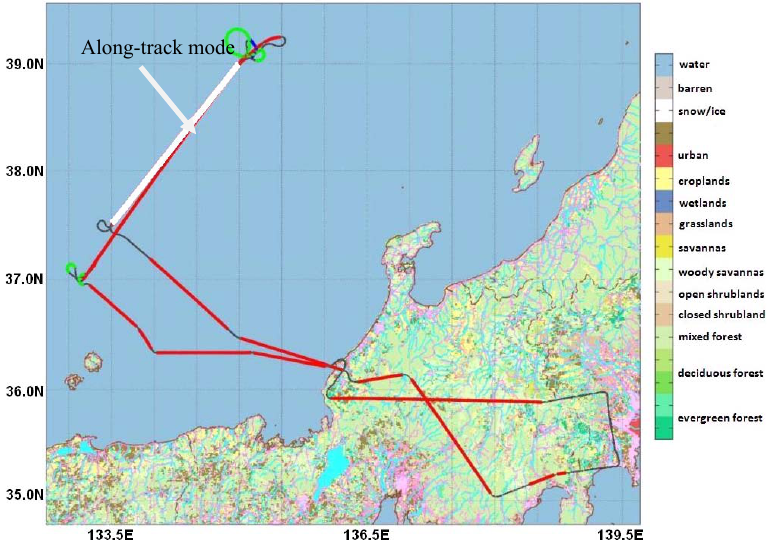
Figure 2: Flight tracks of the NASA P-3 aircraft on 28 January 2003 over the Sea of Japan. White – PSR operated on the along-track mode (the only mode suitable for cloud tomography retrieval); Red – the aircraft flew in a straight and level line; Green – the aircraft flew in a constant angle turns.